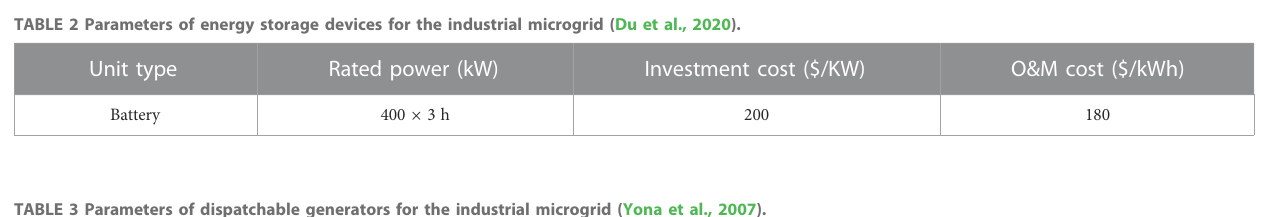
TABLE 3 Parameters of dispatchable generators for the industrial microgrid (Yona et al., 2007).